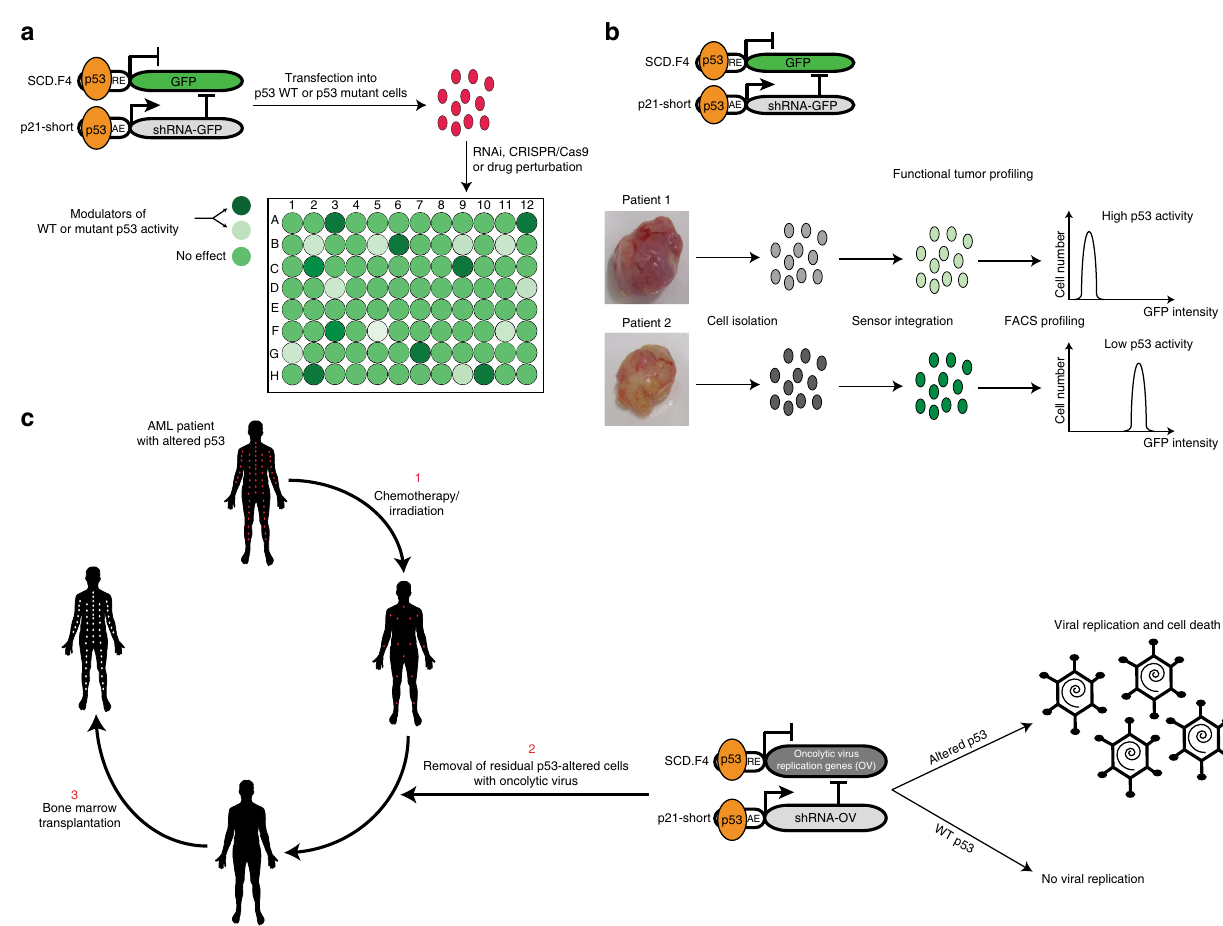
Fig. 6 Possible p53 sensor applications. a Graphical illustration of the sensor ’ s use in large-scale drug or RNAi/CRISPR screens to uncover p53 stabilizers and/or drugs that restore WT p53 function in mutant cells. Important steps are highlighted by arrows. b Functional p53 pro fi ling in primary tumor samples. A model to determine p53 activity in primary cancer cells is presented. c Clinical application of the sensor in AML patients with altered p53. An illustration to couple the sensor to oncolytic viruses and its application in a combination with radiotherapy/chemotherapy before bone marrow transplantation is presented. Red and white dots illustrate leukemic p53 mutant cells and healthy donor cells after transplantation in the patient, respectively. Arrows highlight important